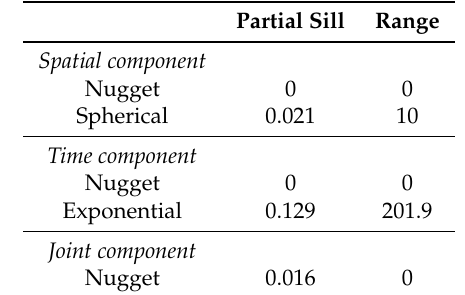
Table 4. Space-time variogram